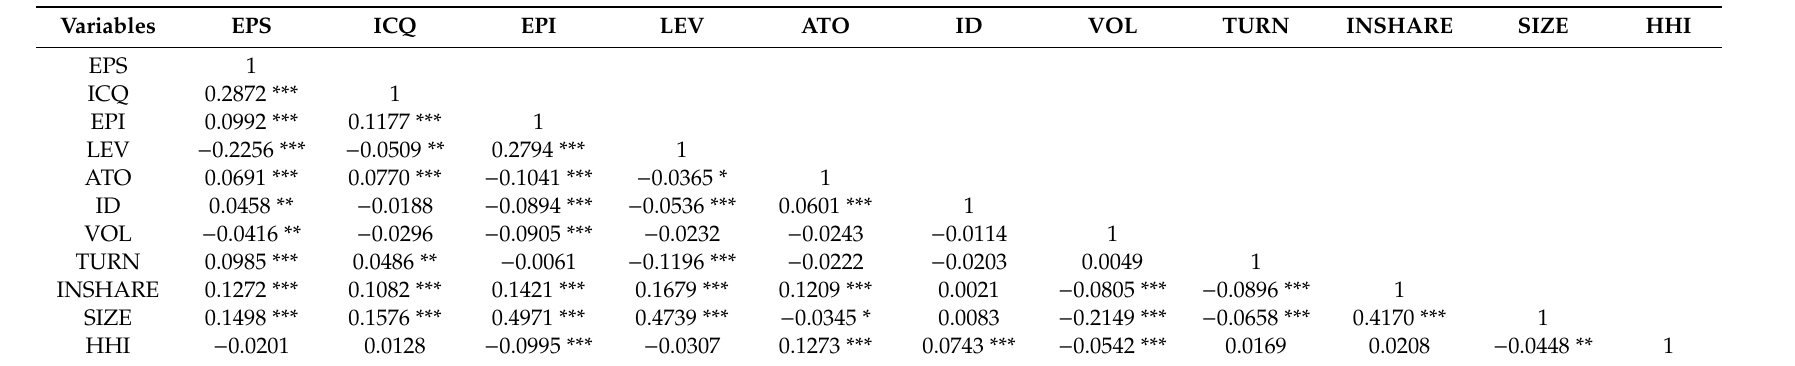
Table 3. Pearson’s correlation coe ffi cients for the full